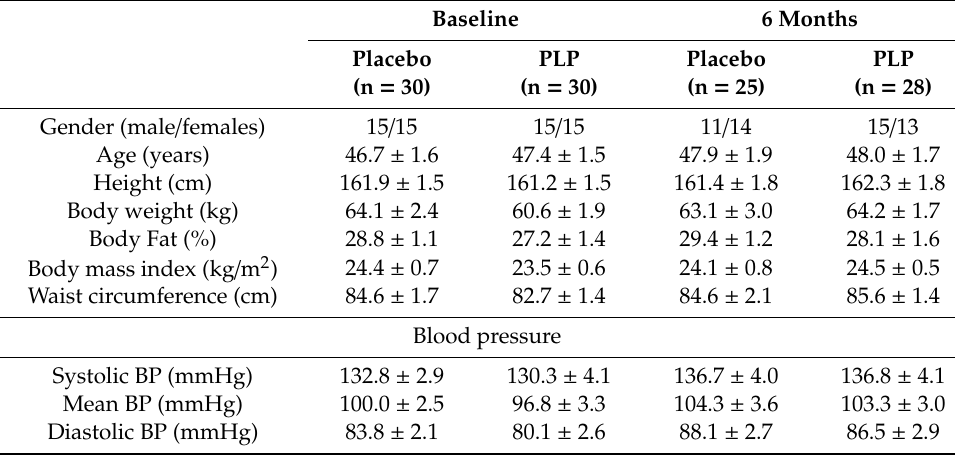
Table 1. Body composition and blood pressure of subjects.